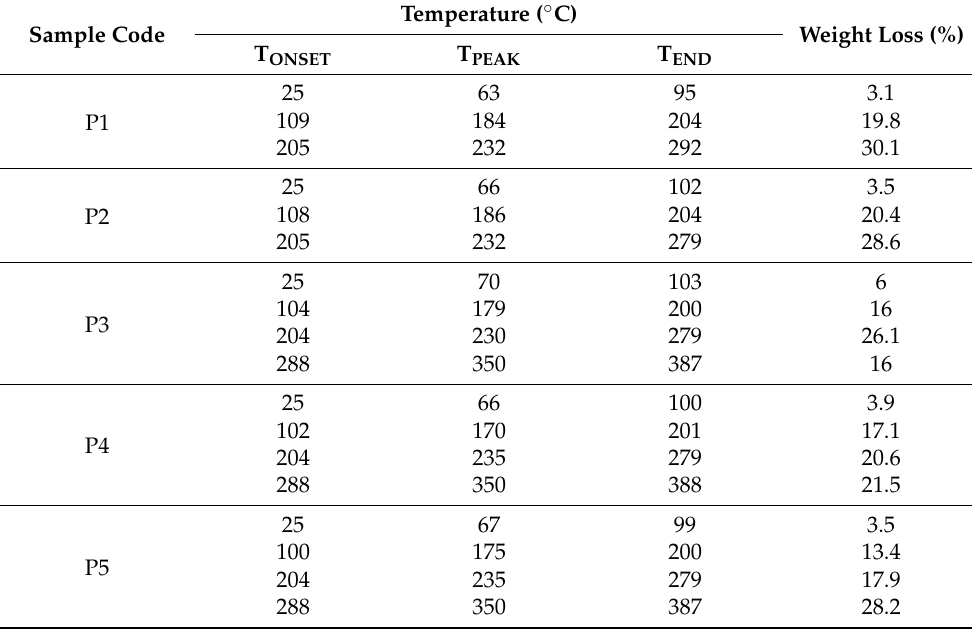
Table 3. Thermogravimetric properties of pectin-based